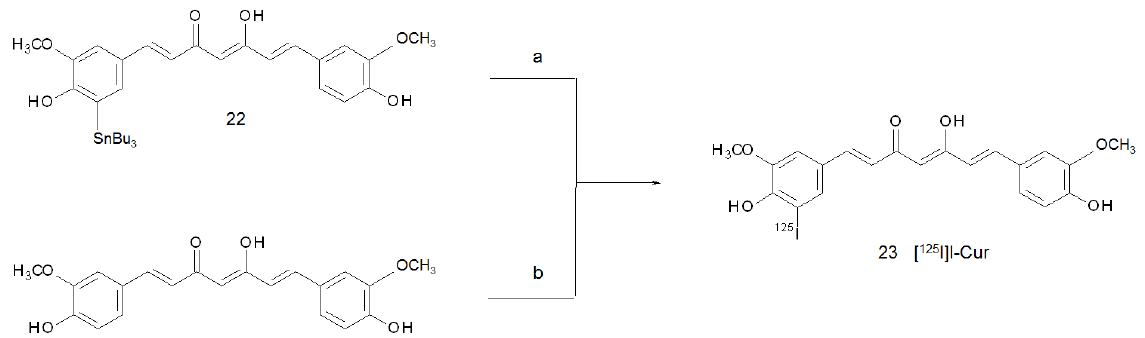
Figure 8. Reagents and conditions: ( a ) Na[ 125 I]I, 1 N HCl, 3% H 2 O 2 , 10 min; ( b ) Iodogen, CHCl 3 , Na[ 125 I]I, RT, 10 min (the product obtained with this path is an assumption of the authors of this review).